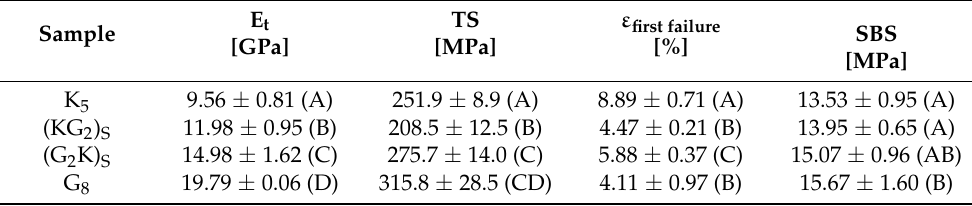
Table 2. Mechanical properties of the